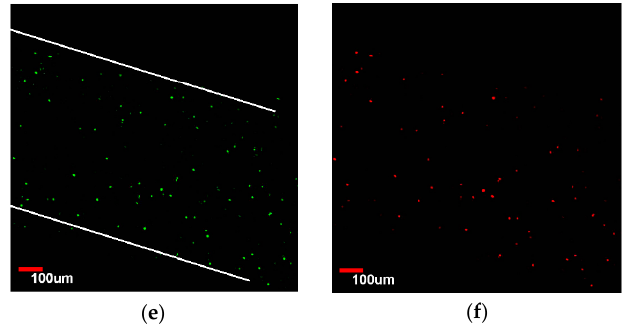
Figure 6. Laser confocal imaging of viability staining. Human umbilical vein endothelial cells (HUVECs) of group Gel-F127 labeled with Live-Dye and propidium iodide after seeding in the macrochannels. Images were taken using a confocal laser scanning microscope. Live and dead cells are fluorescent green and red, respectively. ( a , b ) About 17% dead cells were observed on day 1; ( c , d ) about 27% dead cells were visible on day 3; and ( e , f ) about 35% dead cells were obvious on day 7.